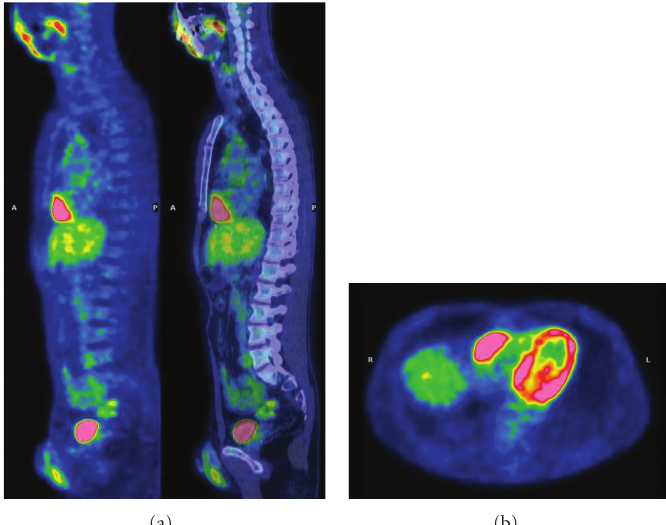
Figure 1: Positron emission tomography/computed tomography (PET/CT) with (18)F-fluoro-2-deoxyglucose showed an intense tracer uptake localized at the right cardiofrenic angle, as shown in transaxial and sagittal views ((b) and (a), resp.).